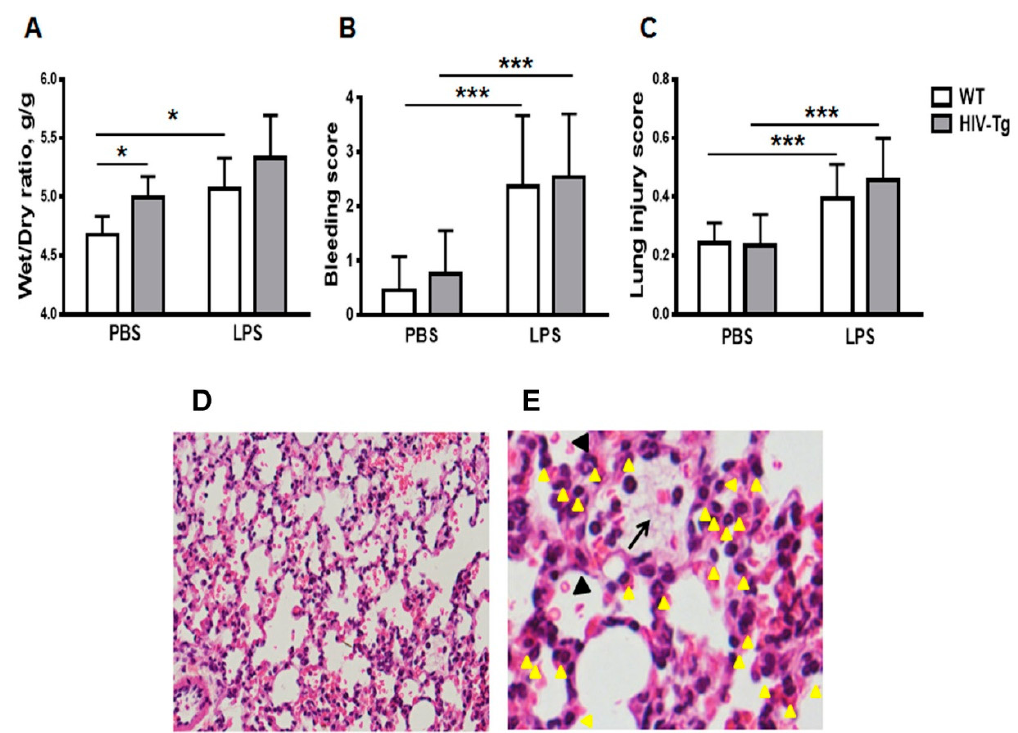
Figure 1. Intraperitoneal lipopolysaccharides (LPS) injections induce similar lung injury in WT and HIV-Tg mice at 6 h post administration. ( A ). Wet-to-dry ratios of lung tissue, ( B ) lung hemorrhage score and ( C ) lung injury score in wild-type (WT) and human immunodeficiency virus 1 transgenic (HIV-Tg) mice at 6 h after administration of either PBS or LPS. Mean and standard error are shown. Asterisks indicate: * p < 0.05 and *** p < 0.001. ( D , E ) Representative images of lung sections from HIV-Tg mouse injected with LPS and stained with hematoxylin and eosin. Original magnifications 100 × ( D ) and 400 × ( E ). Interstitial infiltrated neutrophils are indicated by yellow arrowheads; capillary microtrombi formation is indicated by black arrow; and hemorrhage is indicated by black arrowhead. In contrast, at 24 h post LPS administration HIV-Tg mice demonstrated significantly higher levels of lung injury (Figure 2A,B, WT versus HIV, p = 0.0001). Patchy neutrophilic infiltrates and